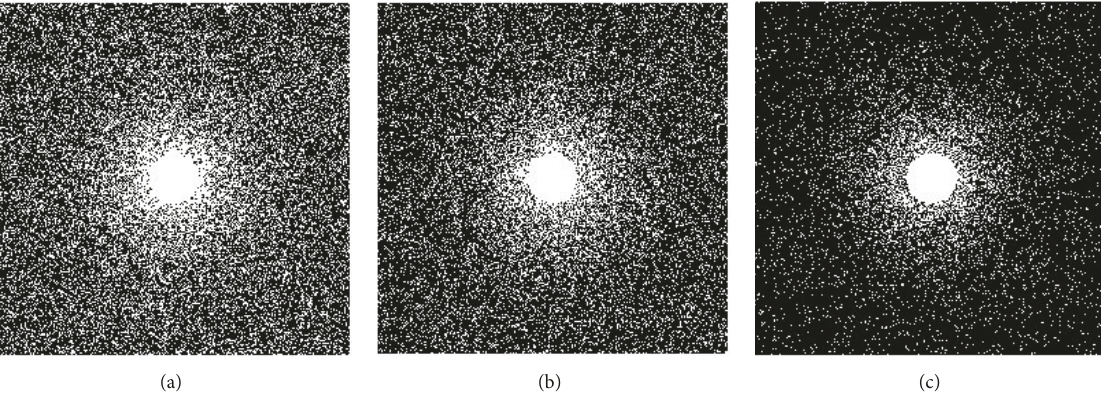
Figure 2: Variable-density sampling patterns for different acceleration rates ( R ): (a) 𝑅 = 3 , (b) 𝑅 = 4 , and (c) 𝑅 = 8 .